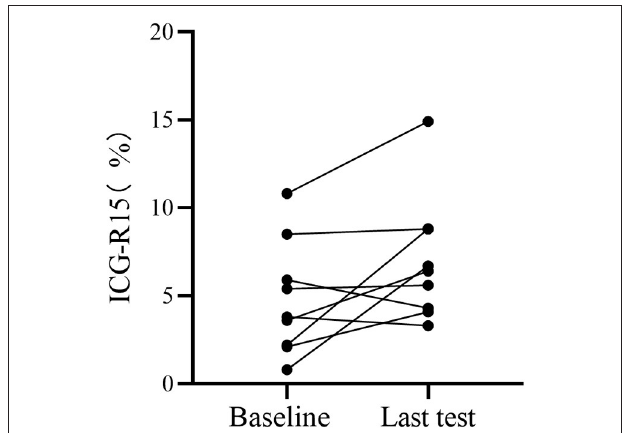
FIGURE 4 | Analysis of hepatic functional reserve in paired ICG clearance tests. Differences in ICG-R15 in last examination compared with baseline. ICG-R15, indocyanine green retention rate at 15min.